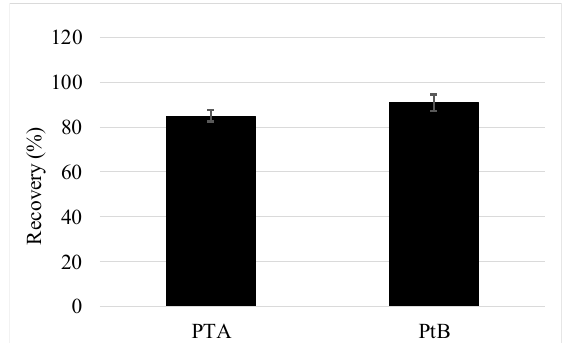
Figure 7. Recovery of PTA and PtB of the entire method (preservation and SPE) at the field (95% confidence limit; n = 6). Relative standard deviation (3–4%) is represent by the error bars.